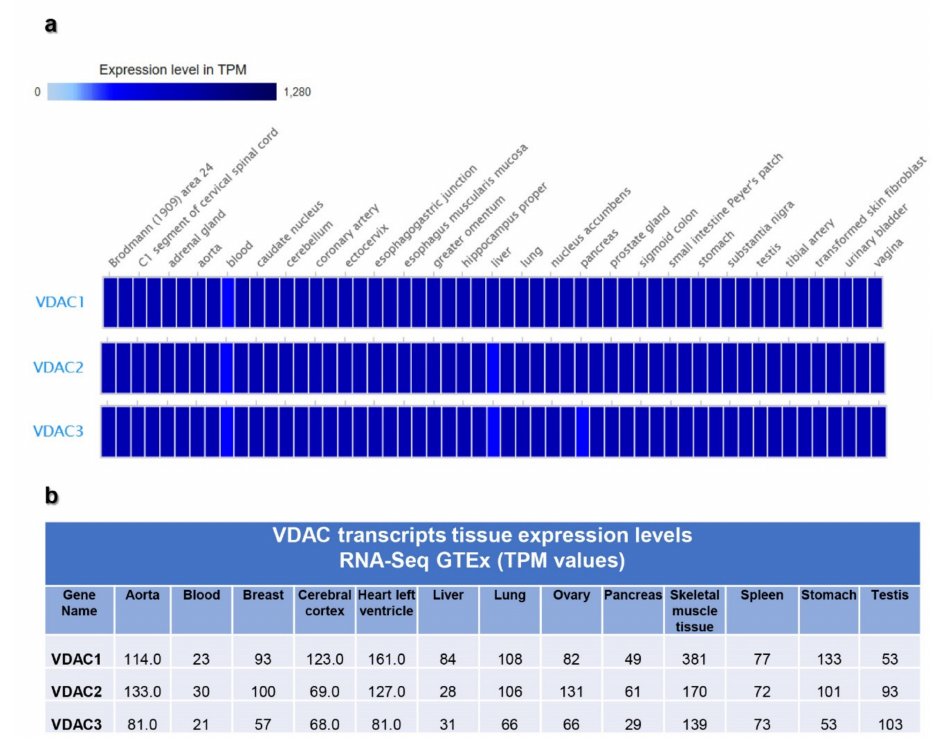
Figure 2. Human VDAC genes expression by Genotype-Tissues-Expression (GTEx) database. RNA-seq data from Genotype-Tissues-Expression (GTEx) project were collected from the Expression Atlas repository, where all data are manually curated and subject to standardized analysis pipelines. The data are displayed in a heatmap ( a ) with di ff erent colors representing a range of transcripts per kilobase million (TPM) mRNA expression levels. The range of expression levels reported for VDAC genes is between 0 and 1280 TPM, as indicated by the bar. In panel ( b ), the specific expression values of each human VDAC isoforms, for representative tissues, are